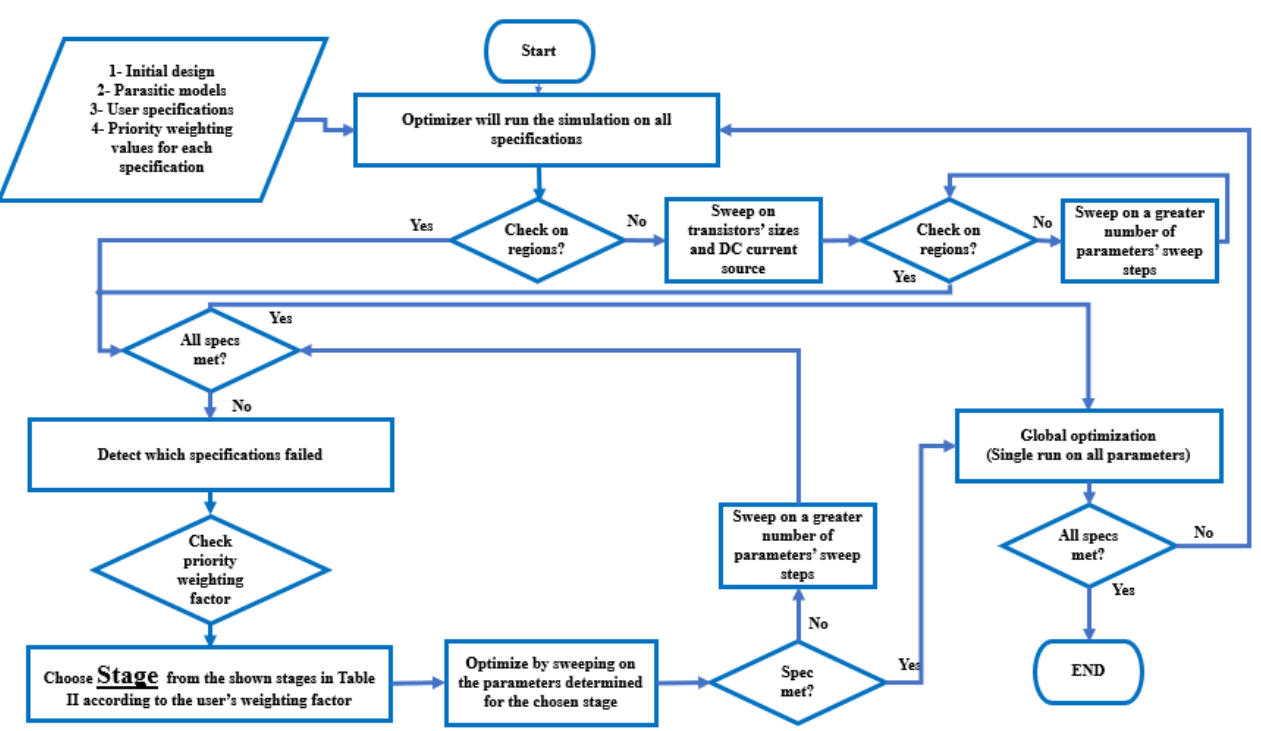
Figure 11. Comprehensive optimization flow chart for the presented optimizer. Table 2. The optimizer different stages with the corresponding parameters to be optimized for the required specification.